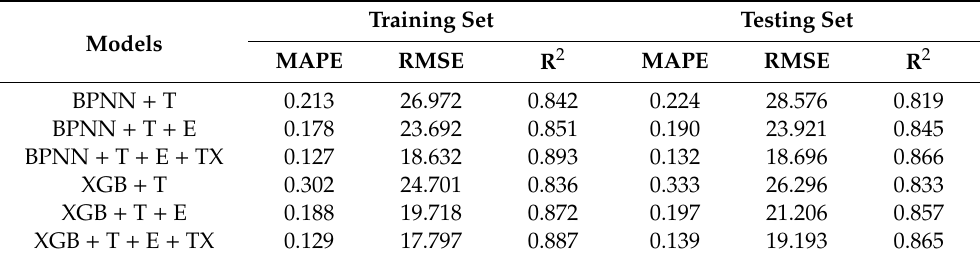
Table 8. Prediction e ff ects of BPNN and XGB.